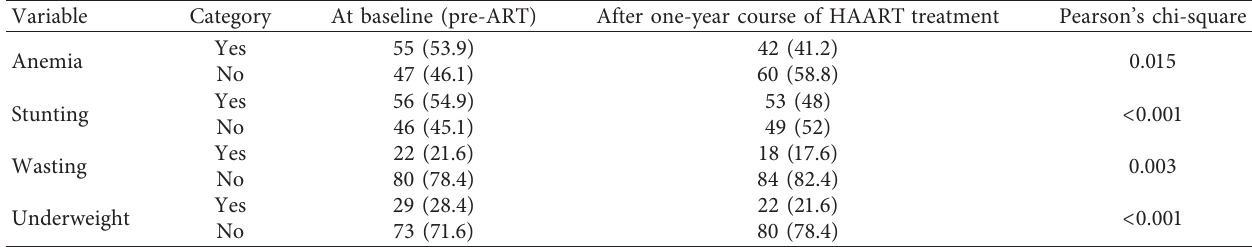
Table 4: Comparison of selected variables using Pearson’s chi-square test before the initiation of ART and one year after the initiation of ART regimen.